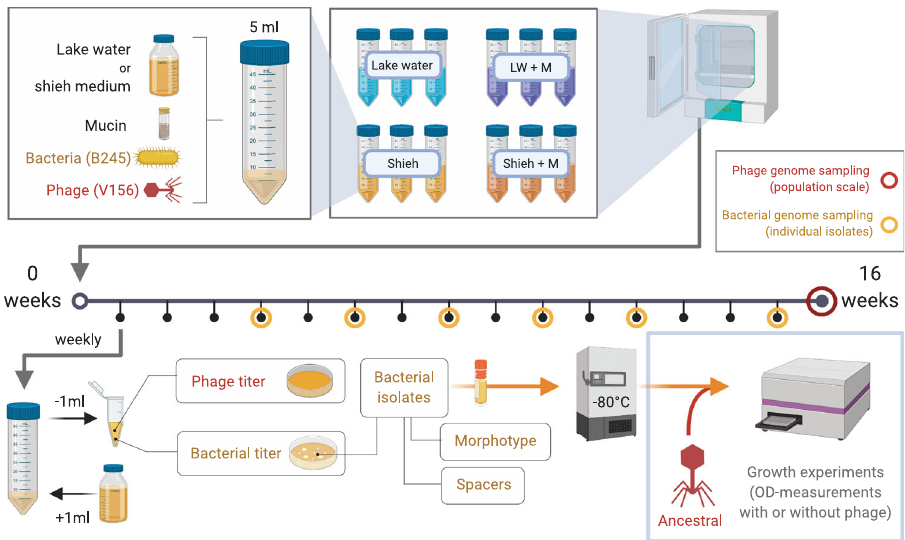
Fig. 1 Overview of the experimental setup. The 16-week experiment (denoted by the horizontal line) contained four culturing conditions, which were sampled and restocked with fresh media weekly. Bacterial isolates were characterized by their morphotype and CRISPR spacer content and used later for growth tests with or without the ancestral phage. Phage genomes (population level) were sequenced at week 16. Genomes from representative bacterial isolates were sequenced throughout the experiment. Figure made in ©BioRender - biorender.com.